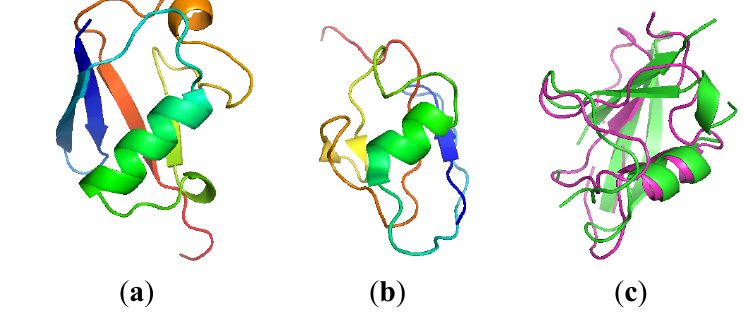
Figure 6. Cartoon structures of the protein 1D3Z ( panel a ) and 1SF0 ( panel b ) show no structural similarity. However msTALI identifies a 2.5 Å of bb-rmsd as shown in panel c (1D3Z is shown in green and 1SF0 is shown in purple).